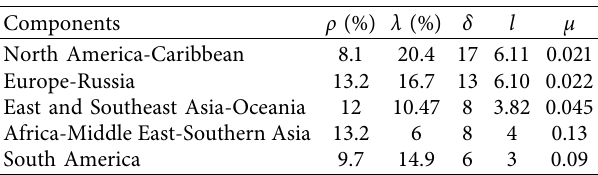
Figure 6: Te fgure at the left represents the fraction of nodes in the LCC of the large local and global components as a function of the fraction of removed nodes under a weighted PageRank attack on the world air transportation network. We also represent the LCC of the world air transportation network in this situation. Te Europe-Russia component and the global component are less sensitive to the attack. Te fgure at the right shows the weighted efciency of the large local and global components as a function of the fraction of removed nodes under a strength attack on the world air transportation network. We also represent the weighted efciency of the world air transportation network in this situation. Te world air transportation network appears as the most vulnerable. Table 6: Basic topological properties of the local components isolated by the weighted PageRank attack. λ is the largest connected component size. ρ is the fraction of top strength nodes removed from the world air transportation network to isolate the compo- nent. δ is the diameter. l is the average shortest path length. μ is the